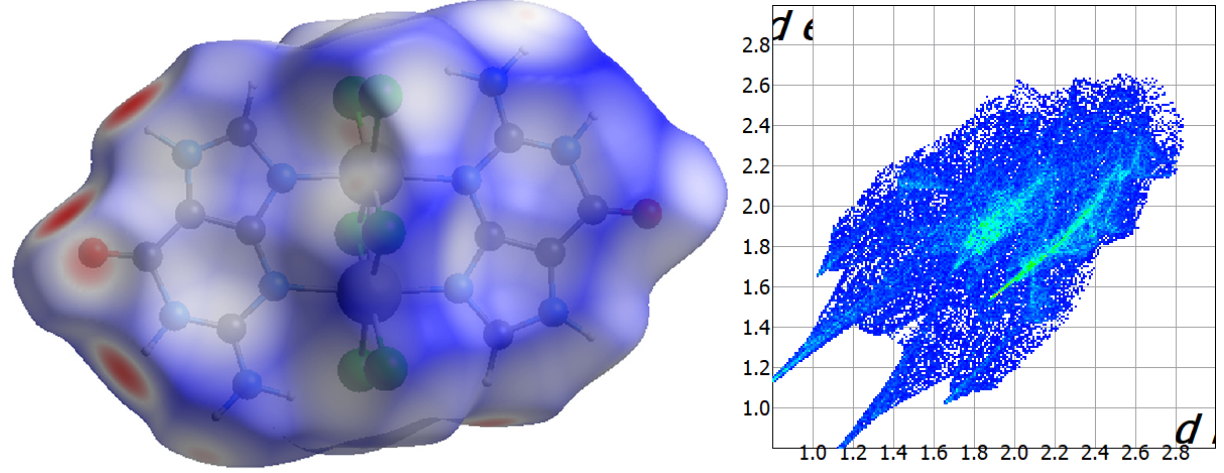
Figure 4. View along the crystallographic c axis of a fragment of the crystal packing of 1 . Water molecules have been omitted for clarity.